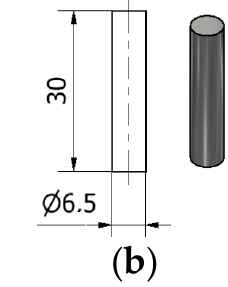
Table 5. Ra average values for the Co–Cr alloys